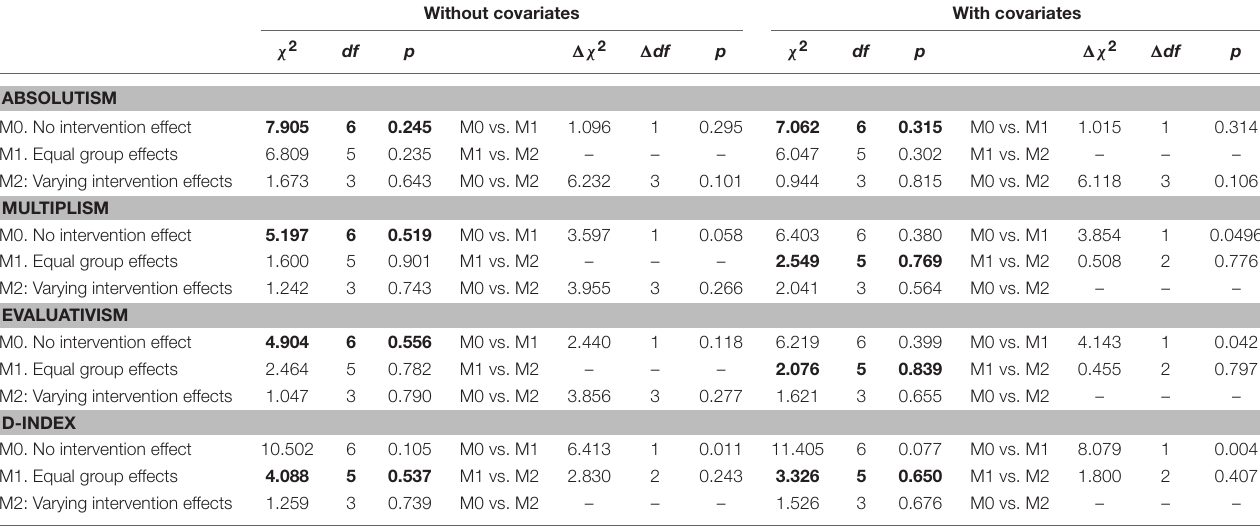
Without covariates